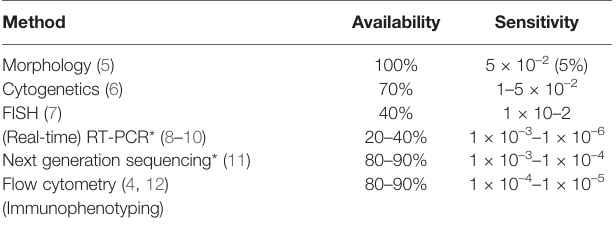
TABLE 1 | Different MRD techniques with availability and